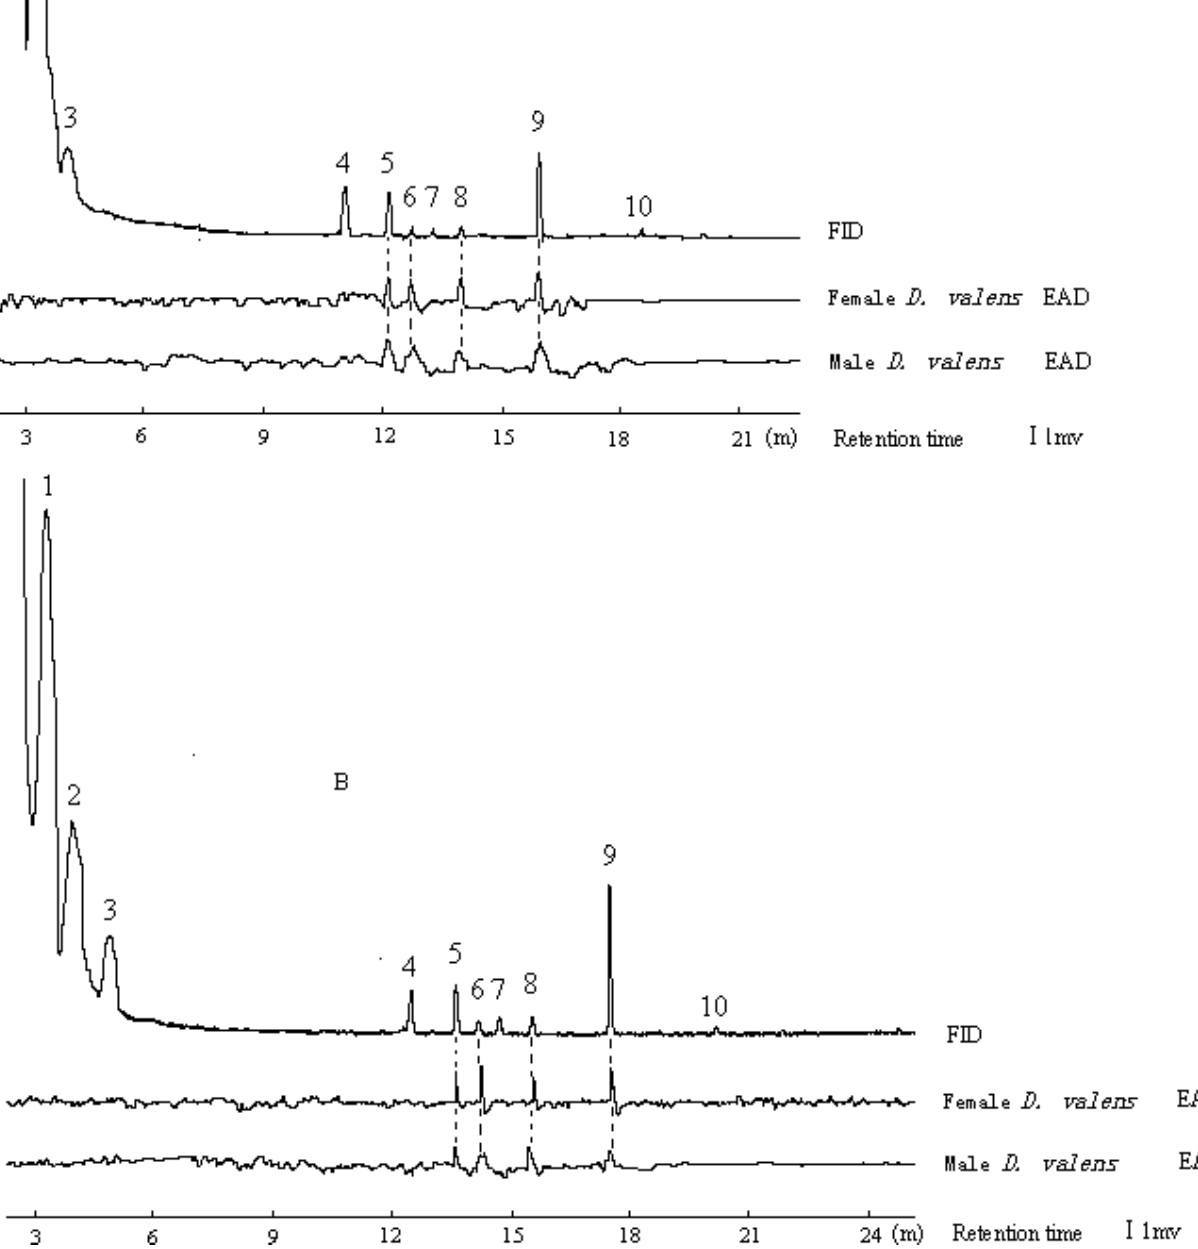
Figure 5. Typical EAD responses of D.valensantennae to male and female H.parallelushindgut extracts. 1 a -pinene, 2 b -pinene, 3 limonene, 4 norinone, 5 myrtenal, 6 trans -verbenol, 7 cryptone, 8 cis -verbenol, 9 myrtenol, 10 isoborneol.